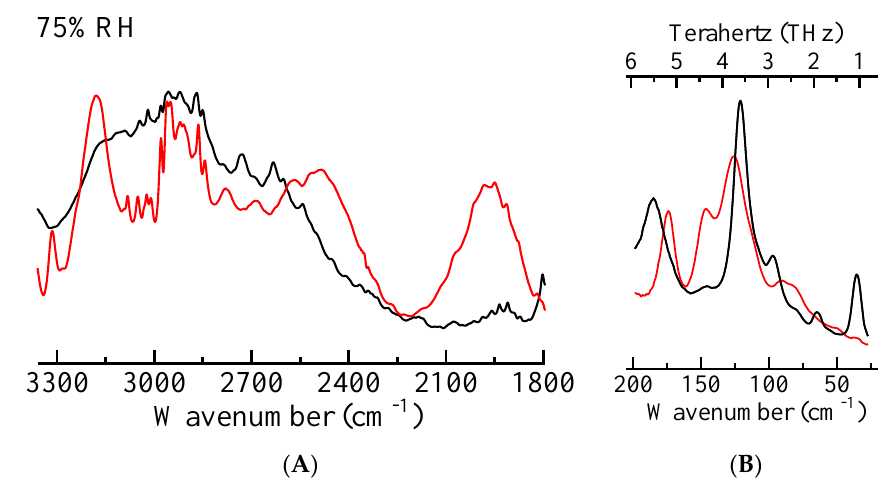
Figure 2. Pre-processed ( A ) Fourier-transform infrared spectroscopy (FT-IR) and ( B ) terahertz (THz) spectra at 75% relative humidity (RH). Black and red lines indicate the physical mixture (PM) spectrum and the spectrum of the last sampling point, respectively.